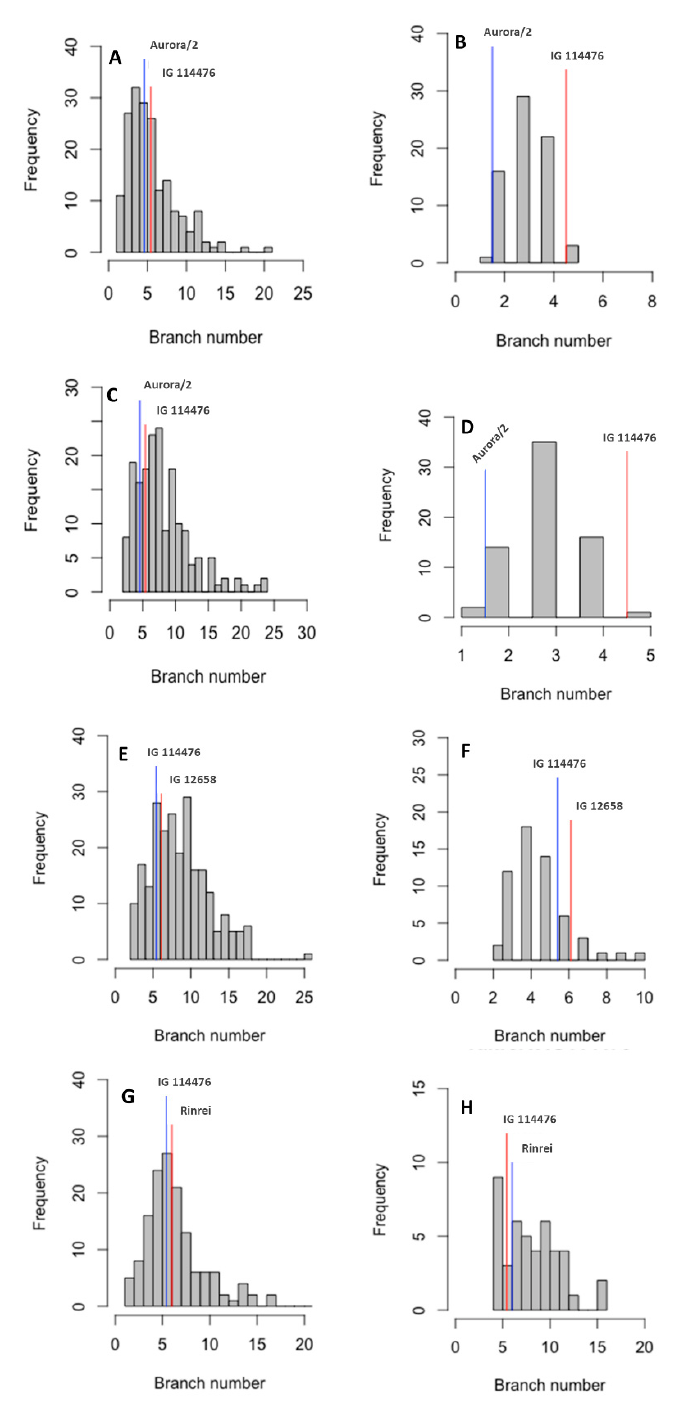
Figure 2. Frequency distributions of the number of branches for F 2 populations. ( A ) IG 114476 × Aurora / 2, field (n = 185, P (W) = 0.001); ( B ) IG 114476 × Aurora / 2, growth chamber (n = 71, P (W) = 0.115); ( C ) Aurora / 2 × IG 114476, field (n = 177, P (W) = 0.001); ( D ) Aurora / 2 × IG 114476, growth chamber (n = 68, P (W) = 0.001); ( E ) IG 114476 × IG 12658, field (n = 239, P (W) = 0.001); ( F ) IG 114476 × IG 121658, growth chamber (n = 61, P (W) = 0.132); ( G ) IG 114476 × Rinrei, field (n = 144, P (W) = 0.001); ( H ) IG 114476 × Rinrei, growth chamber (n = 44, P (W) = 0.001). P (W), P value of Shapiro–Wilk test for normality.